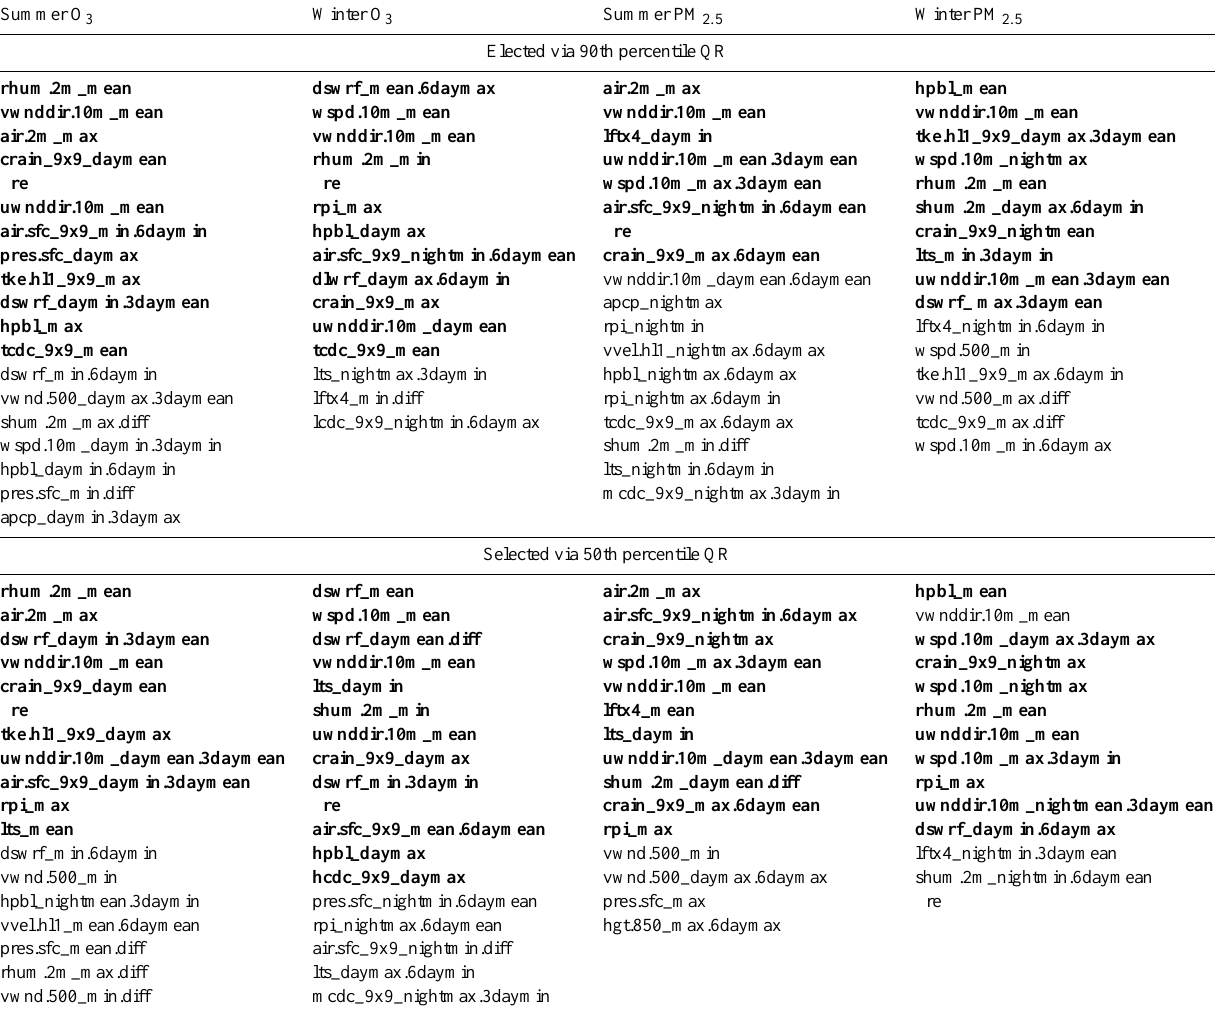
Table 2. Selected covariates for O 3 and PM 2 . 5 using 90th percentile (above) and 50th percentile (below) quantile regressions. “Core” covariates (in bold) were selected using a minimum threshold for summed inverted ranks of at least 2, with remaining covariates added by rerunning the selection procedure including all core variables and a relaxed selection threshold of